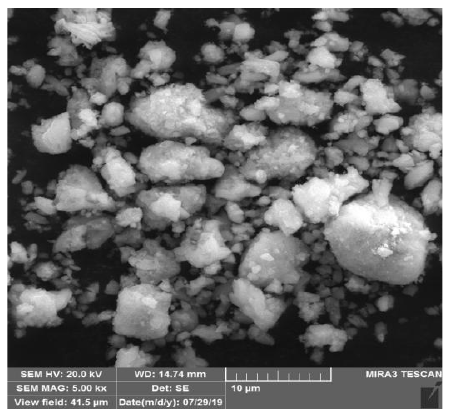
Figure 8. SEM images of RE(OH) 3 .